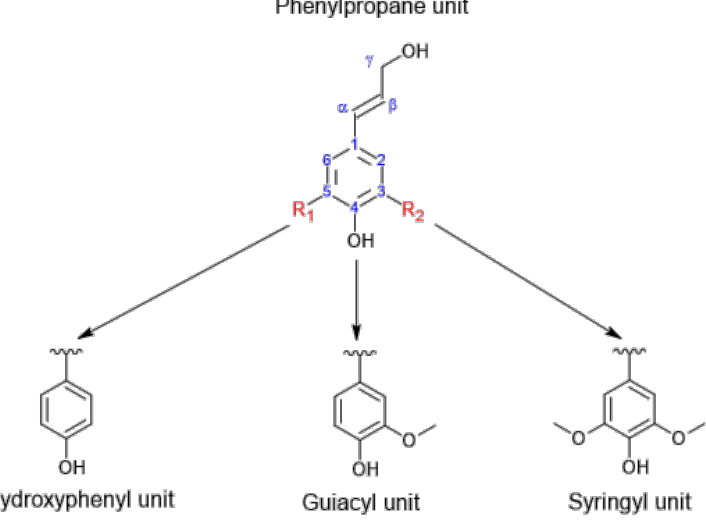
Figure 2. Phenylpropane unit and building units of lignin.